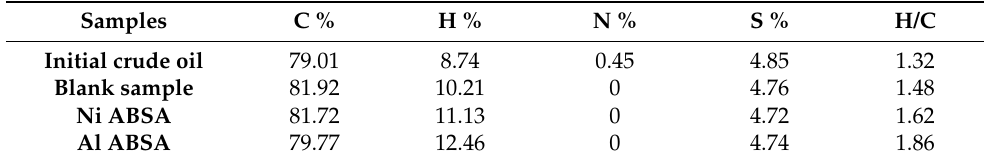
Table 2. The elemental composition of crude oil samples.